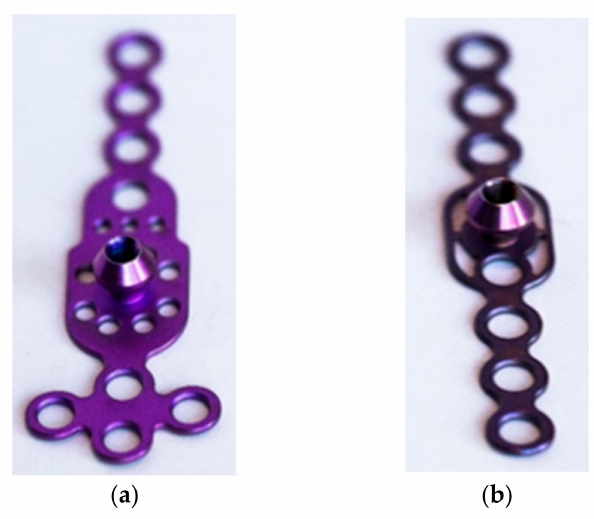
Figure 1. Plates employed in this study: ( a ) HENGG-1; ( b ) HENGG-2.